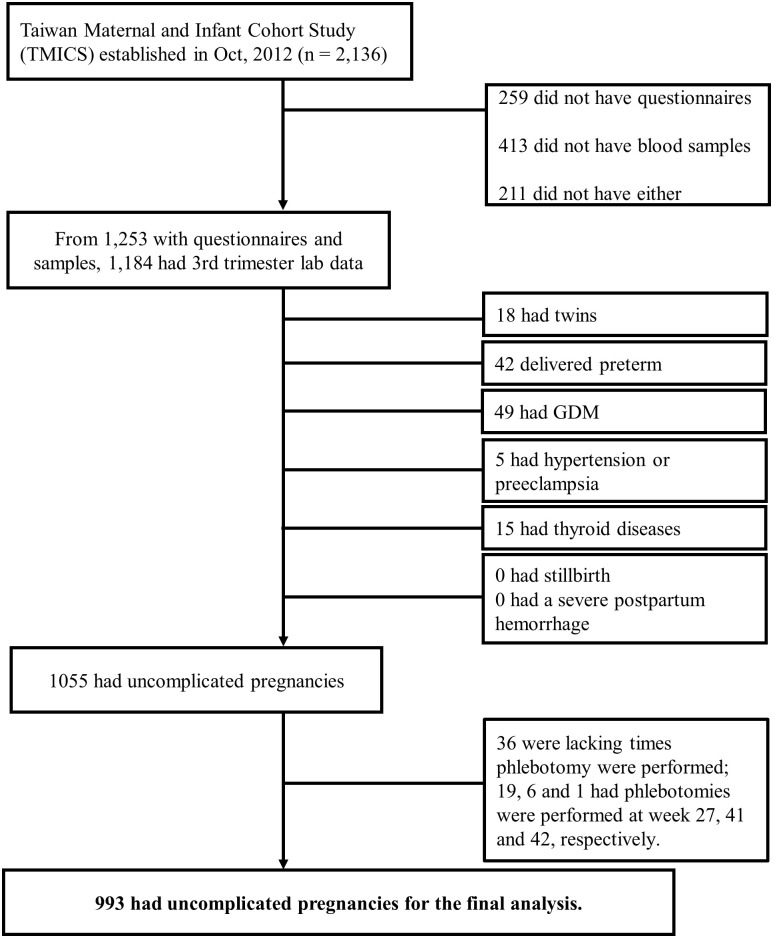
Study flowchart.